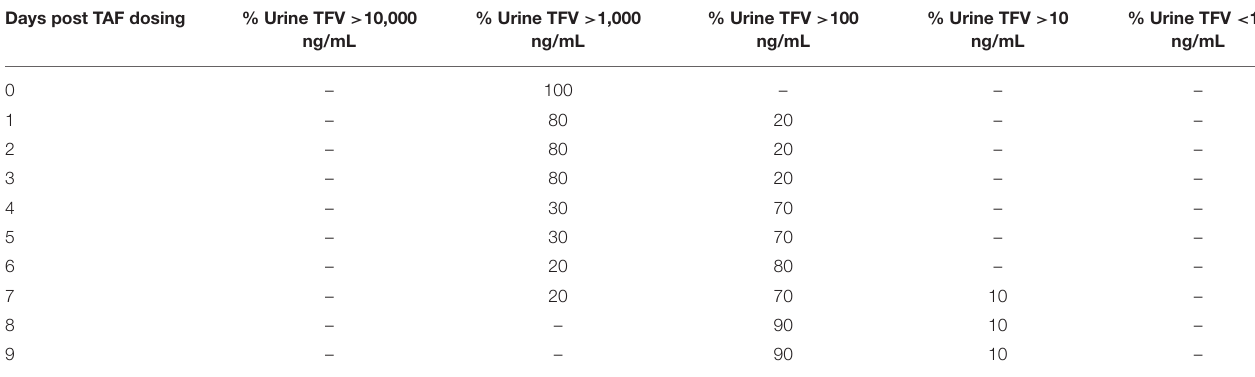
TABLE 3 | Observed urine concentrations from the seven dose cohort. Days post TAF dosing